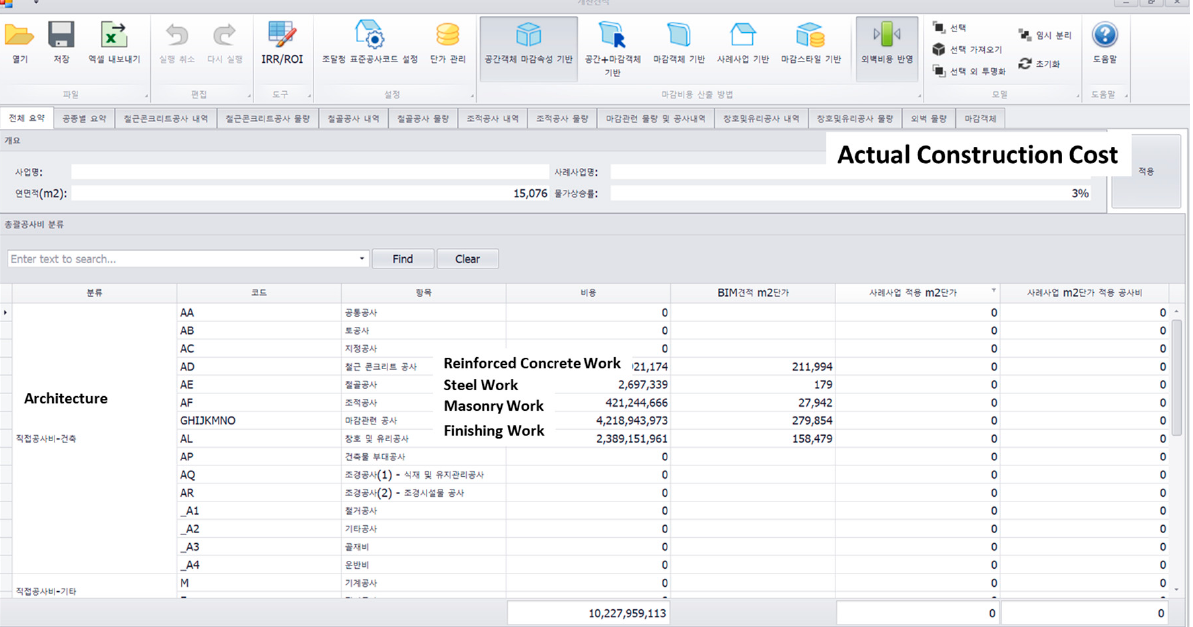
Figure 10. Approximate construction cost result screen: total construction cost.